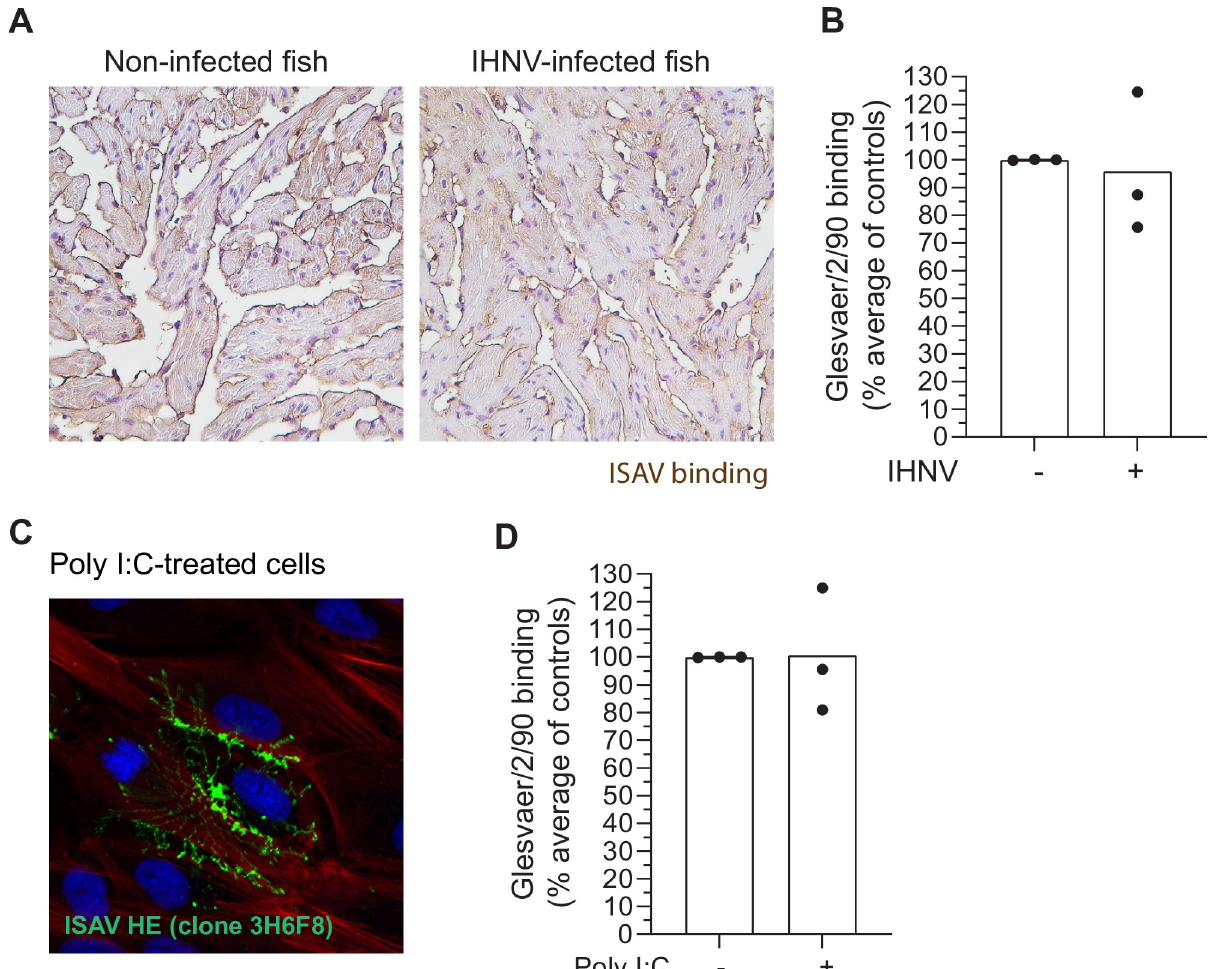
Fig 5. ISAV binding is not affected by the general antiviral response. (A) Virus histochemistry in non-infected and IHNV-infected fish (n = 3 fish per group). (B) Virus binding assay in IHNV-infected ASK cells. (C) Representative micrographs visualising ISAV binding in poly I:C-treated ASK cells. (D) Virus binding assay in poly I:C-treated ASK cells. (B and D) Dots show normalised means from three independent experiments. Bars show mean values.